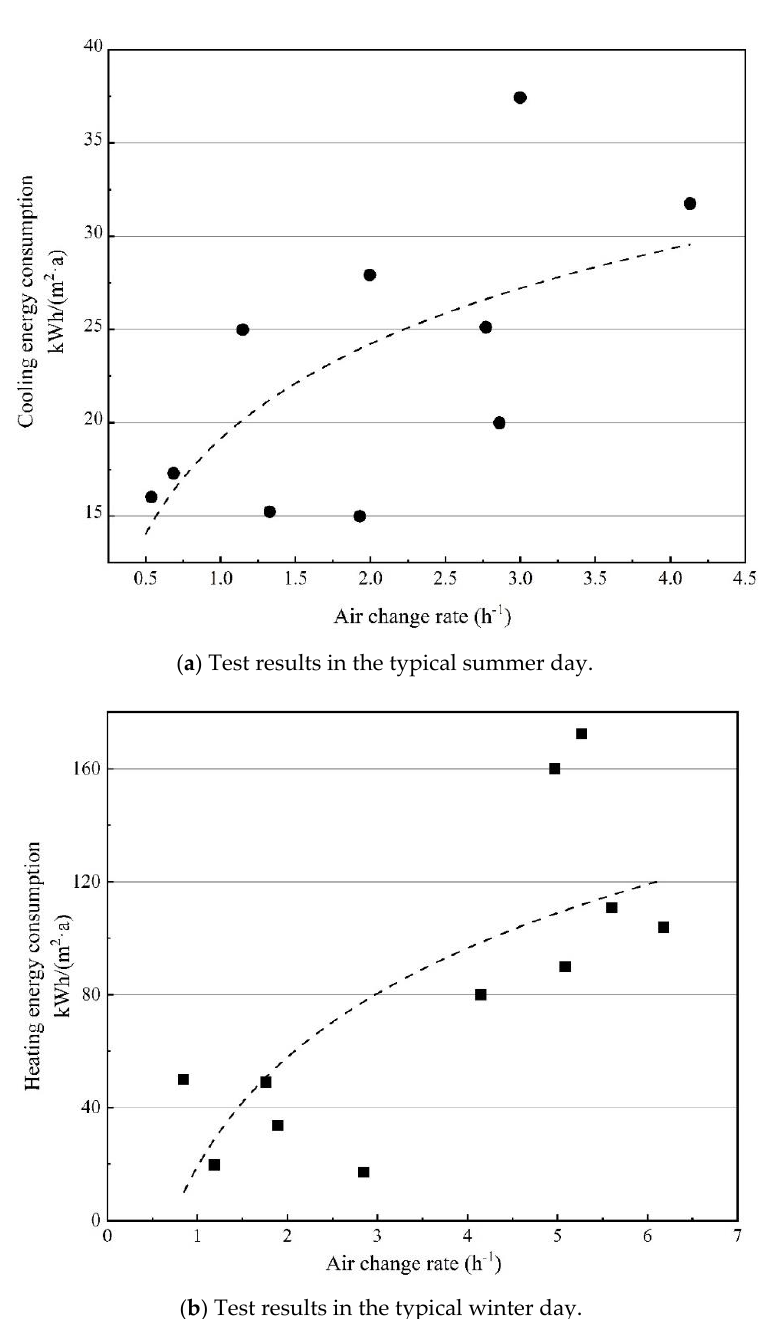
Figure 13. The relationship between air infiltration and energy consumption.